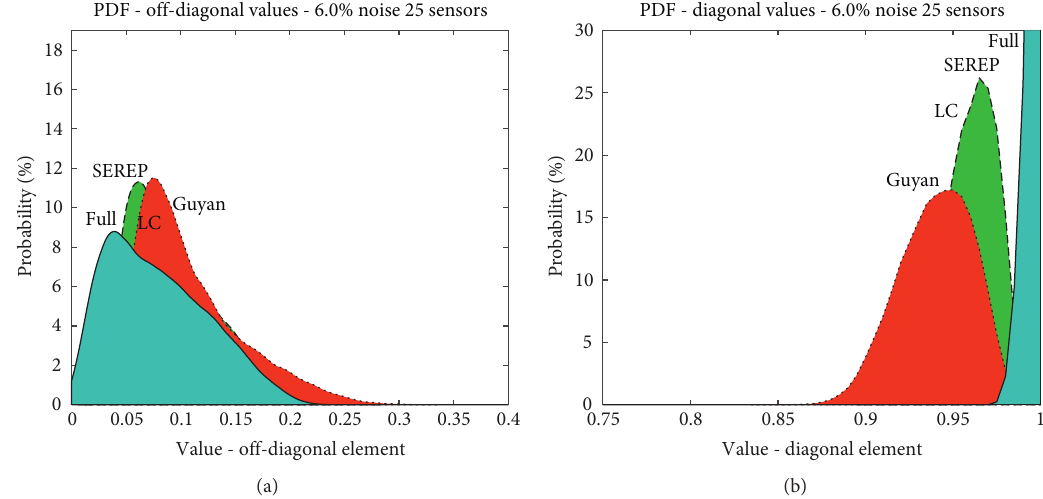
Figure 9: (a) PDFs of the maximal off-diagonal elements. (b) PDFs of the minimal diagonal elements. Both with 6 pct. Noise on the modes and 25